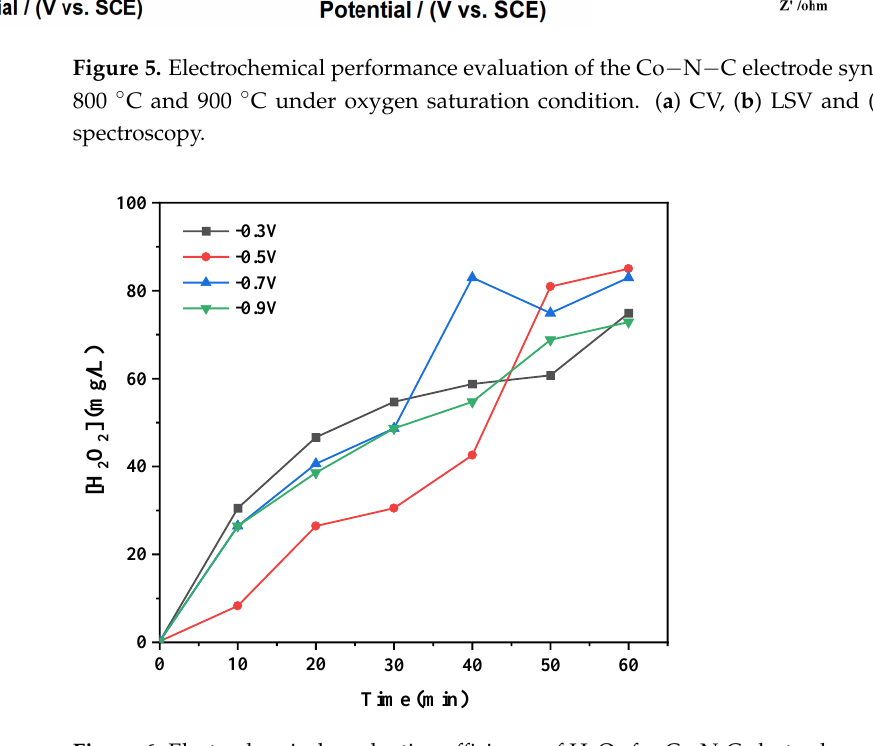
Figure 6. Electrochemical production efficiency of H 2 O 2 for Co-N-C electrode synthesized at 800 °C under different applied voltages.